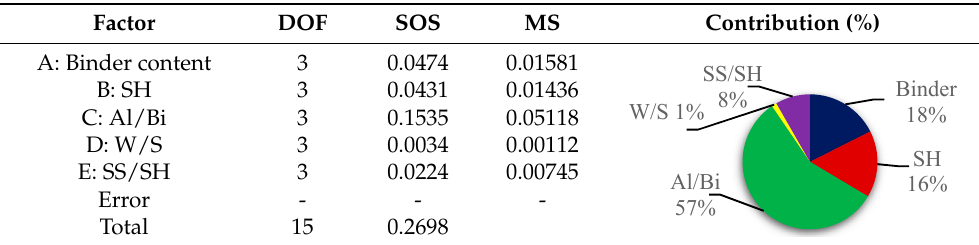
Table 7. ANOVA results of grey relational grade.